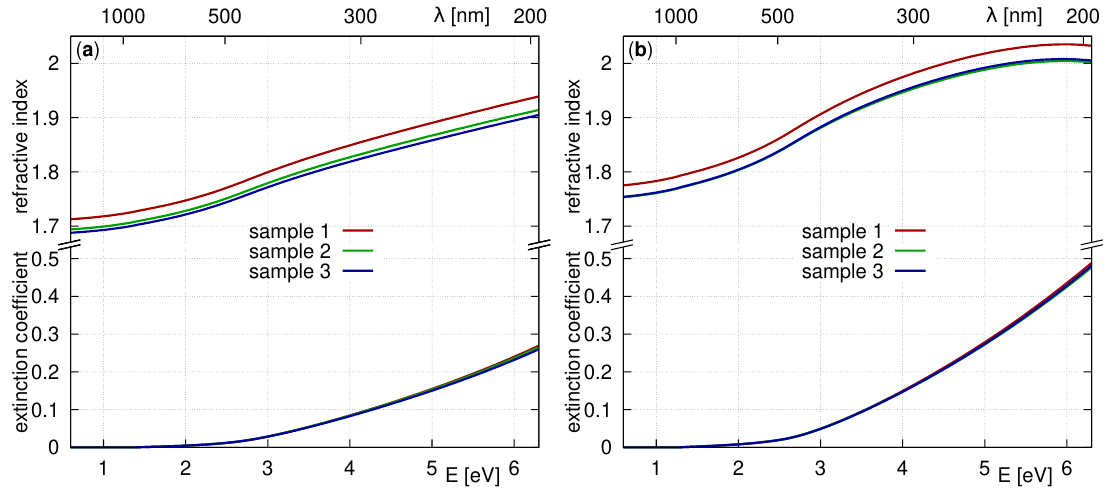
Figure 3. Spectral dependencies of the optical constants of the inhomogeneous films at the lower boundary for: ordinary wave ( a ); and extraordinary wave ( b